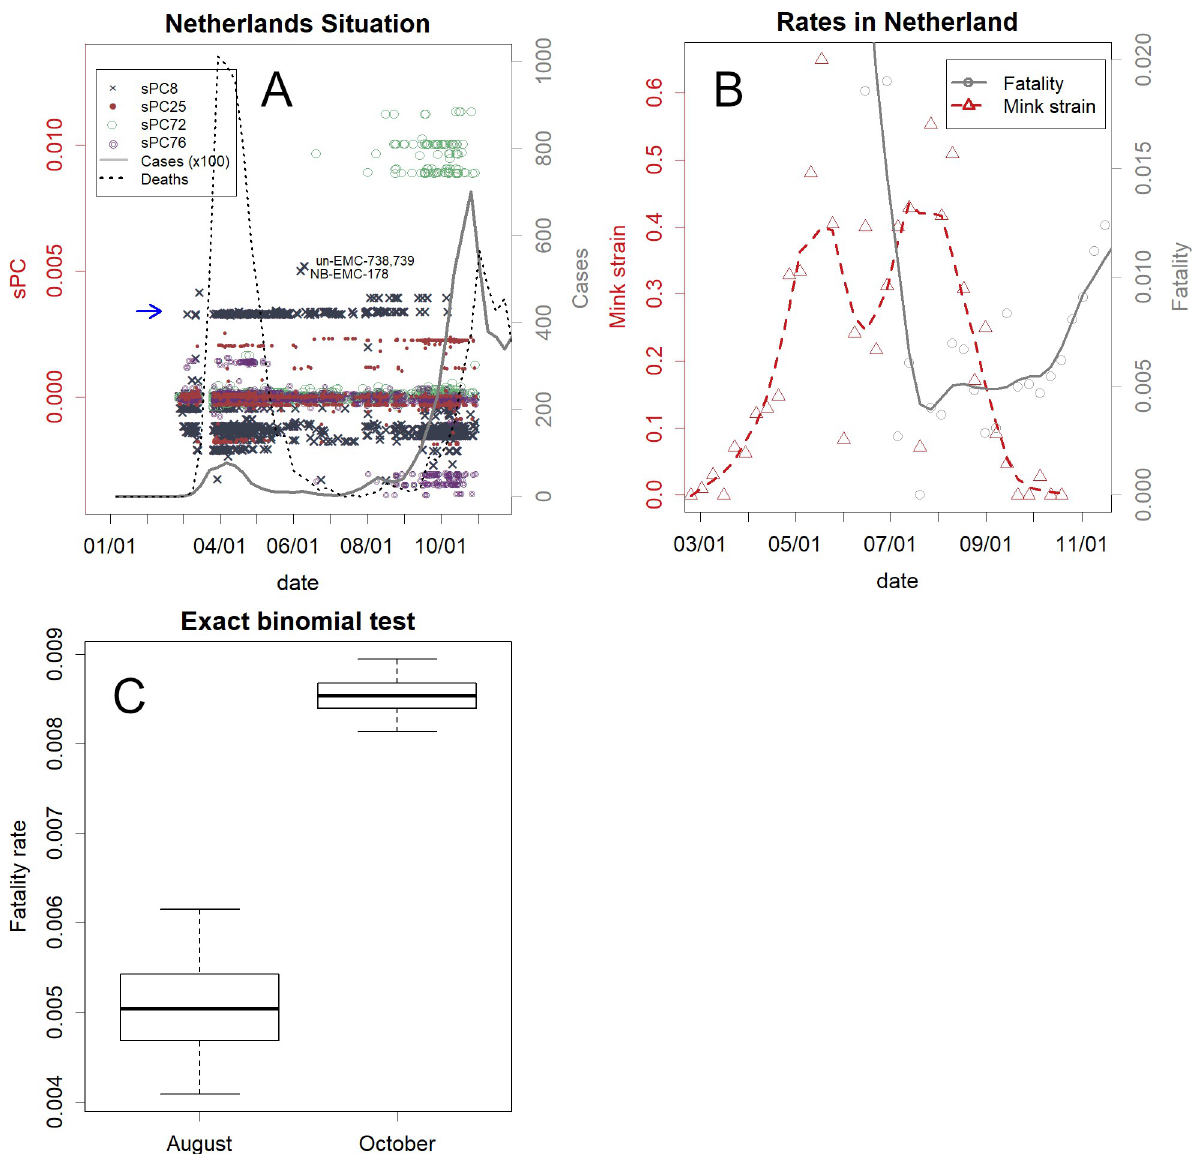
Fig 2. The SARS-CoV-2 outbreak in the Netherlands. A . Number of confirmed cases, deaths, and PC for human-virus. Before the second wave, variants had changed (coloured points of specified axes of PCs). The mink-derived human-virus appeared at and above the level of PC8 (x) indicated by the blue arrow. B . Rates of fatality (number of deaths in the following week/cases, grey) and the mink-derived variants (red). C . Comparison of fatality rates in August and October. The thick horizontal line indicates the estimation of the rate. The whiskers show 95% confidence intervals, and the boxes show the quartiles. The situation in Denmark is presented in S1